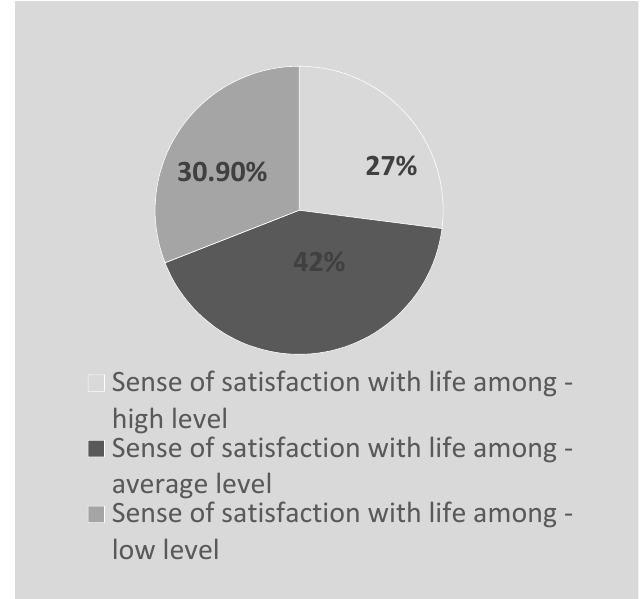
Figure 3. Sense of satisfaction with life among the respondents.